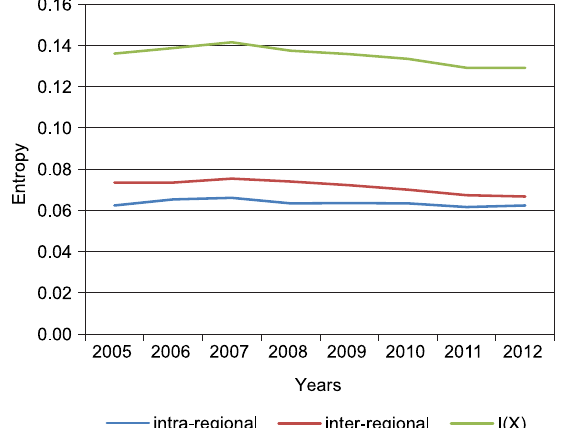
Fig. 3. Inequality in Poland on the scale of regional per cap - ita income in the years 2005-2012 on the basis of the entropy measure of